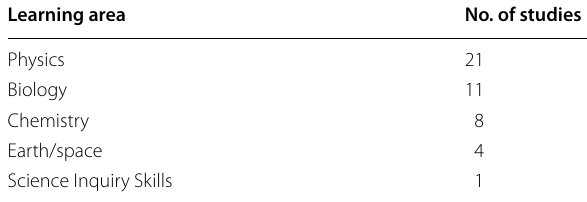
Table 3 Science learning areas addressed in